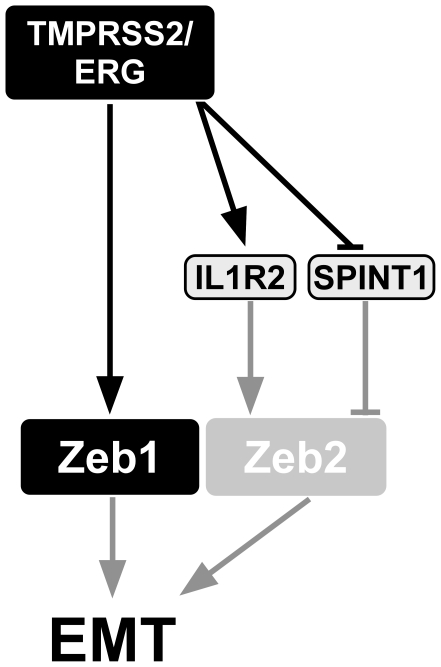
A schematic model describing the proposed mechanism by which TMPRSS2/ERG induces EMT.Black lines represent novel data; arrowheads represent activation; bar-headed lines represent repression; grey lines represent literature-based data.